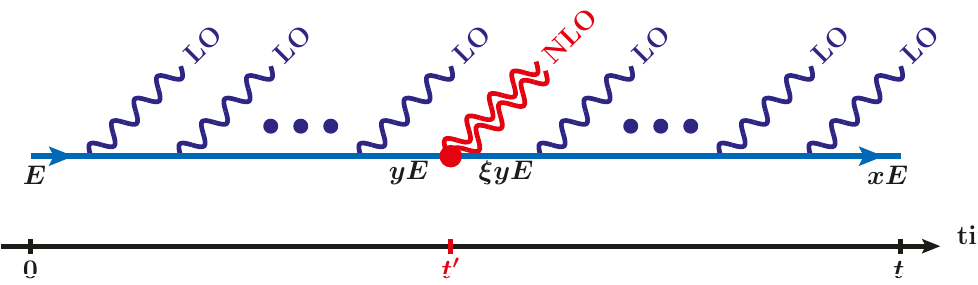
Figure 18 . A picture of following the original charge through a shower for a case where exactly one of the splittings involving that charge is a next-leading-order splitting.